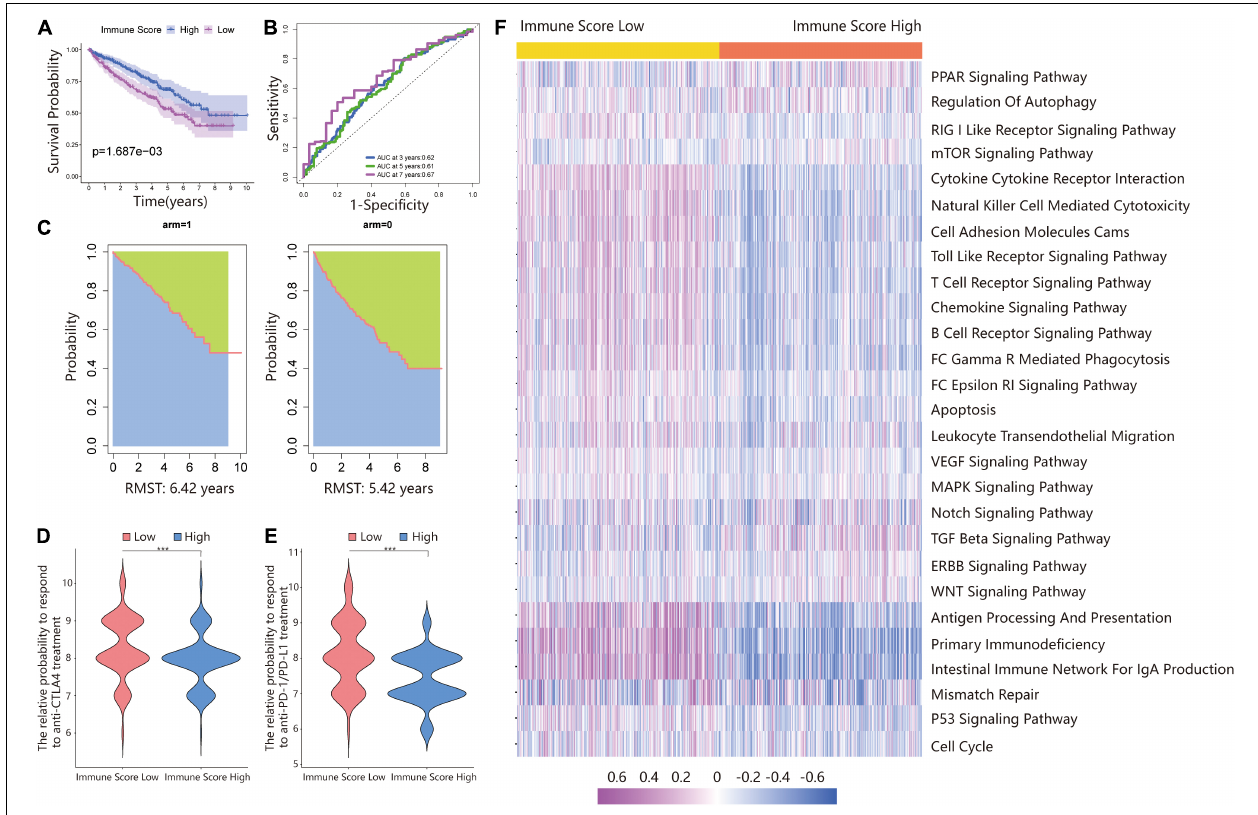
FIGURE 3 | Validating the immune score in the total dataset. (A) Survival analysis of the ISL group and ISH group in the total set. In these two groups, the Kaplan–Meier curve with a log-rank p -value of 0.002 showed significant survival differences. (B) Time-dependent ROC curve analysis of the immune score in all samples. The 3-, 5-, and 7-year AUCs in all samples were 0.62, 0.61, and 0.67, respectively. (C) The RMS curve for the immune scores was plotted for all ccRCC samples. In the ISL and ISH groups, the RSM times were 6.42 and 5.42, respectively. The blue part represents the RMS time, and the green part represents the restricted mean time lost (RMSL). (D,E) Relative probabilities of anti-CTLA4 and anti-PD-1/PD-L1 treatment between the ISL and ISH groups in the total set. (F) Gene set variation analysis (GSVA) enrichment analysis of the activation states of biological pathways in distinct immune score groups. These biological processes are shown in the heatmap. Purple represents the activated pathway, and blue represents the inhibited